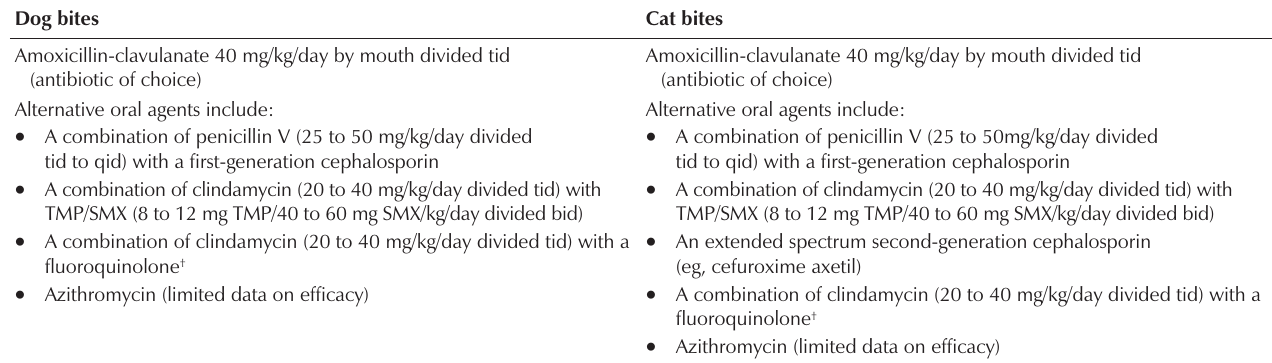
Amoxicillin-clavulanate 40 mg/kg/day by mouth divided tid (antibiotic of choice)